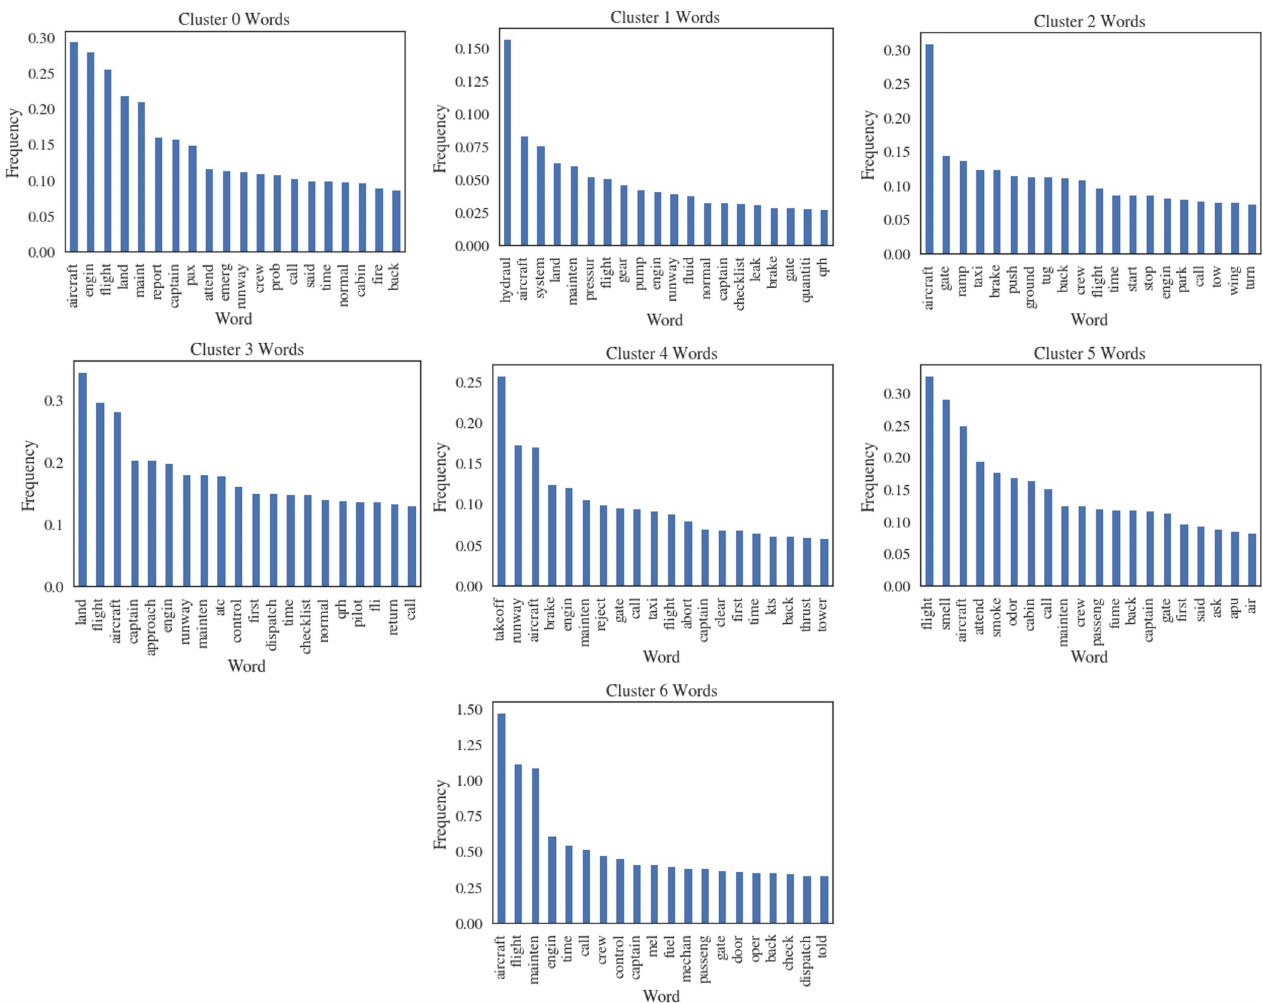
Figure 3. Most Frequent 20 Words of Each Main